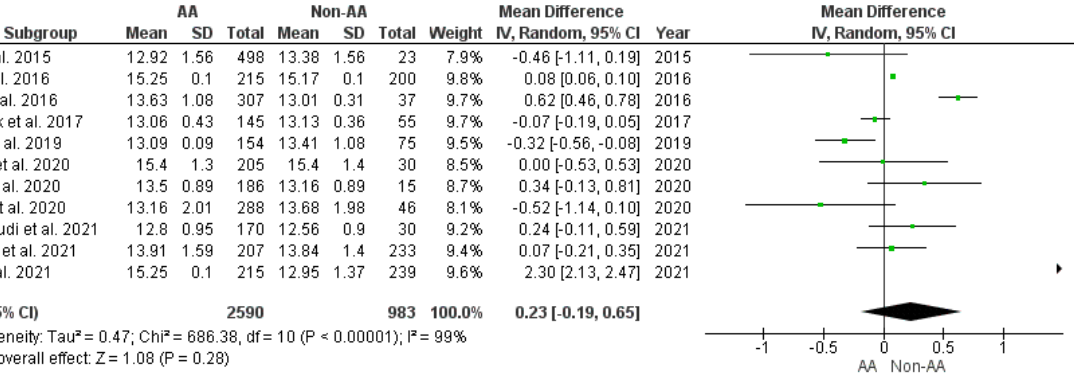
Figure 3. Forest plot comparison between the two patient groups (AA versus non-AA) in terms of the average values of red cell distribution width. Abbreviations: AA—acute appendicitis; non-AA— non-acute appendicitis; IV—inverse variance; and CI—confidence interval.